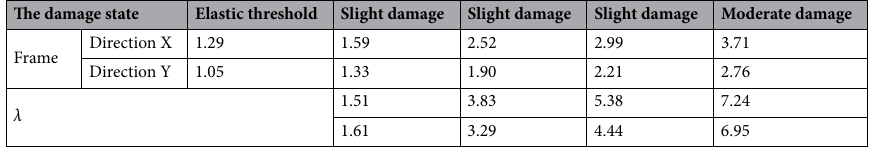
Table 4. Calculation results of the